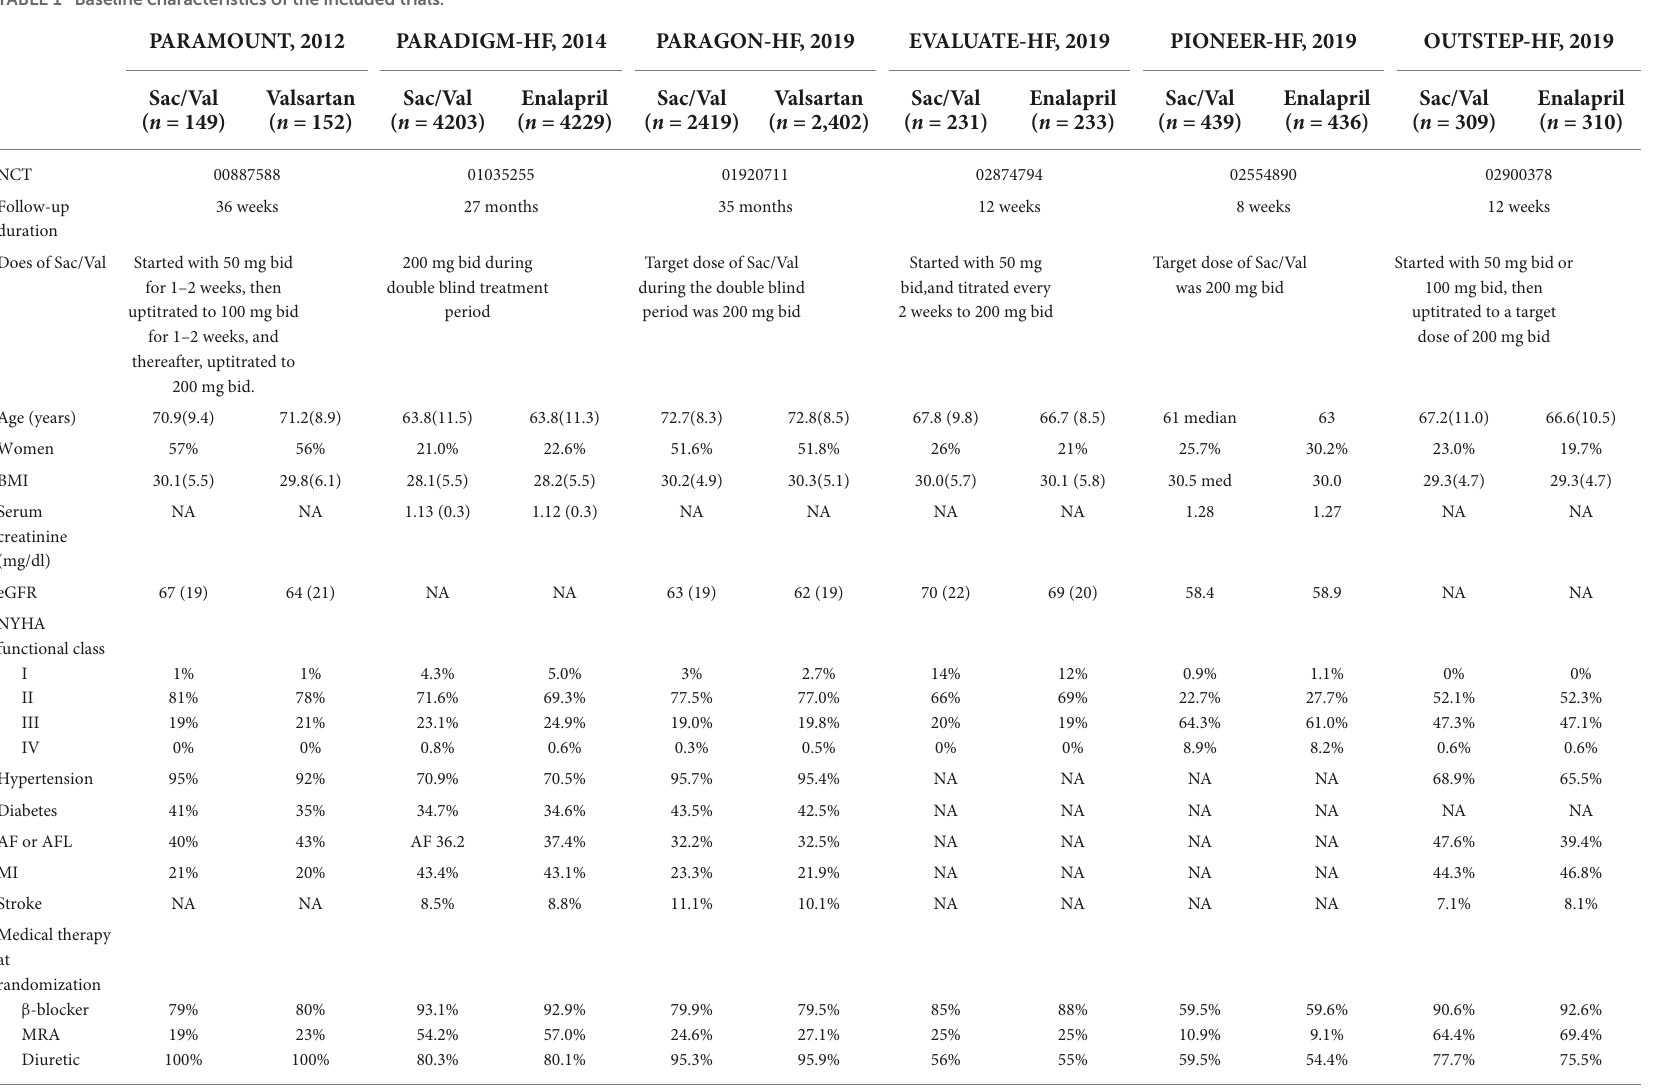
TABLE 1 Baseline characteristics of the included